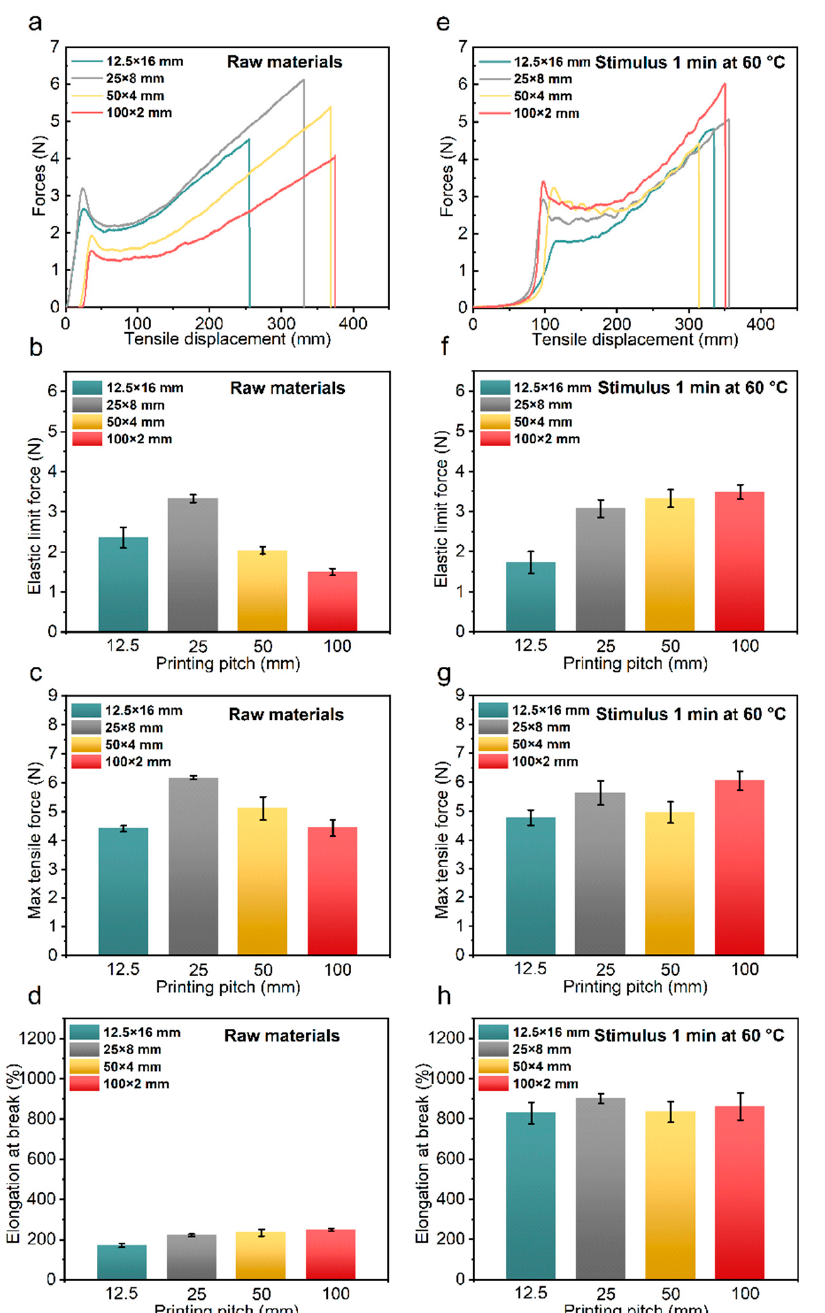
Figure 2. Force and tensile displacement curves of the unstimulated bio-inspired spider silk samples with different nodes ( a ); elastic limit force ( b ); maximum tensile force ( c ); elongation at break ( d ). Force versus tensile displacement curves of bio-inspired spider silk samples with different nodes stimulated at 60 ◦ C for 1 min ( e ); elastic limit force ( f ); maximum tensile force ( g ); elongation at break ( h